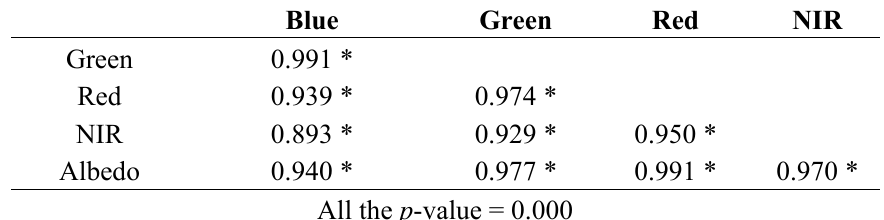
Table 4. Pearson correlation between reflectance and albedo.